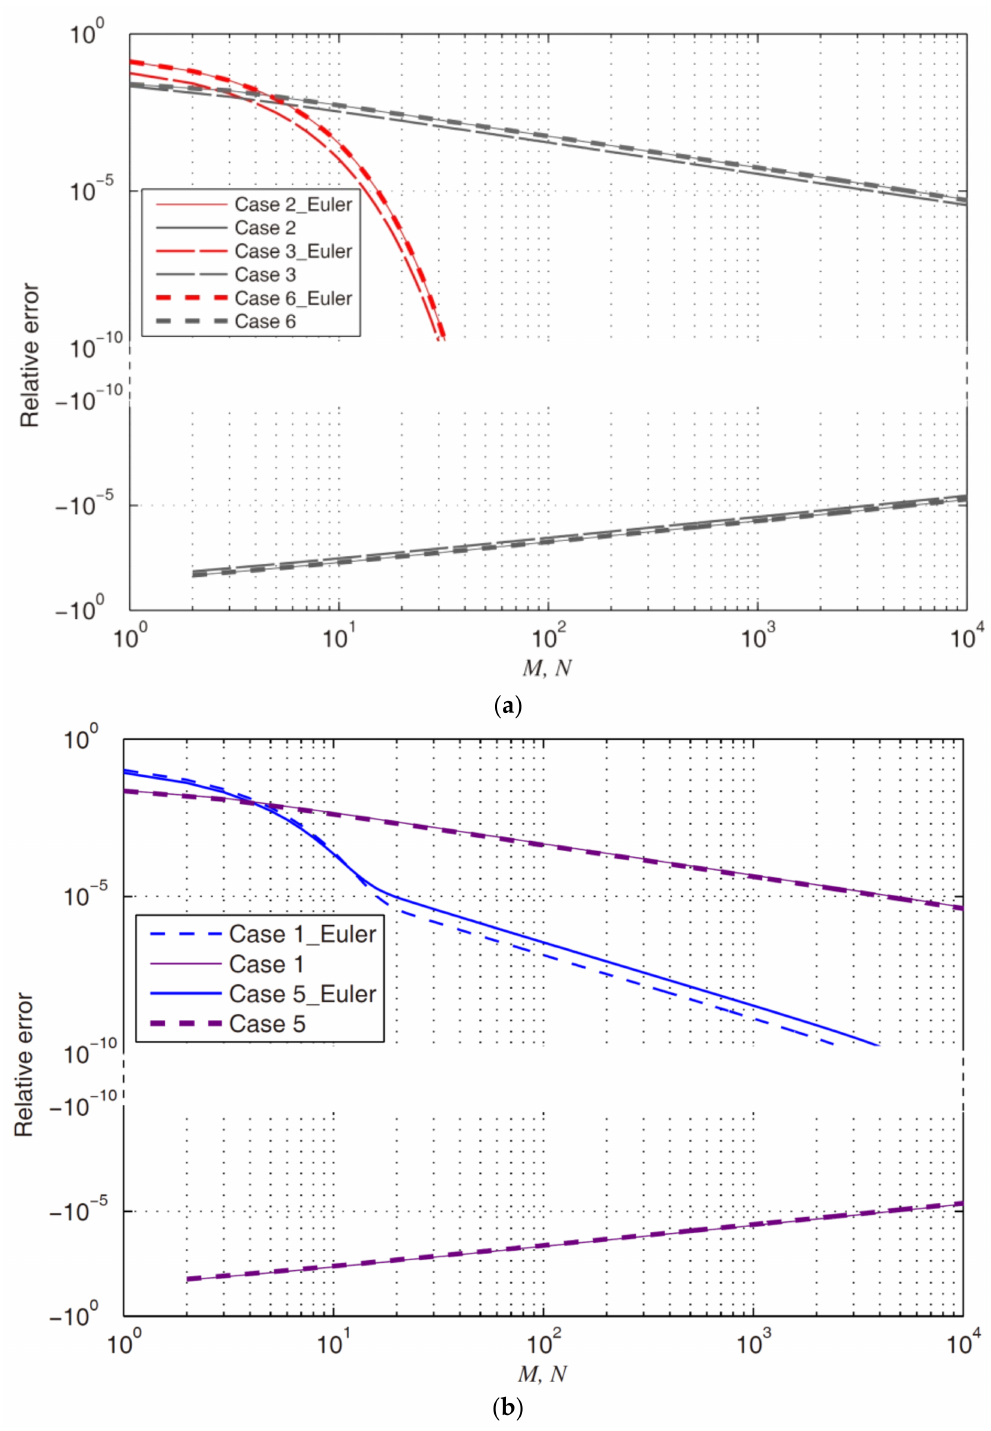
Figure 5. Convergence processes of inter-well pressure difference predicted by the monotonic series invoking Euler transform, compared with those predicted by the original alternating series for ( a ) Cases 2, 3, and 6 and ( b ) Cases 1 and